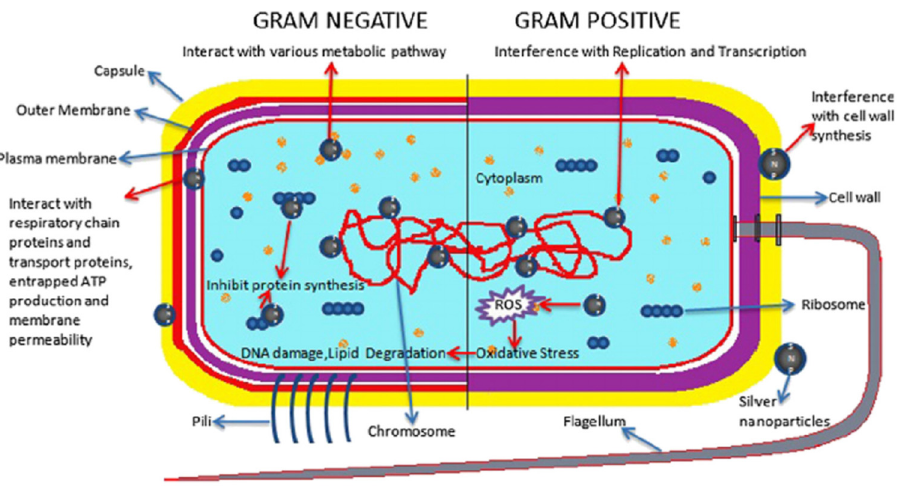
Figure 14. An example of the disinfection mechanism of an antimicrobial agent (silver nanoparticles) on the bacteria. (Reprinted with permission from [86]. Copyright 2019 Elsevier.).